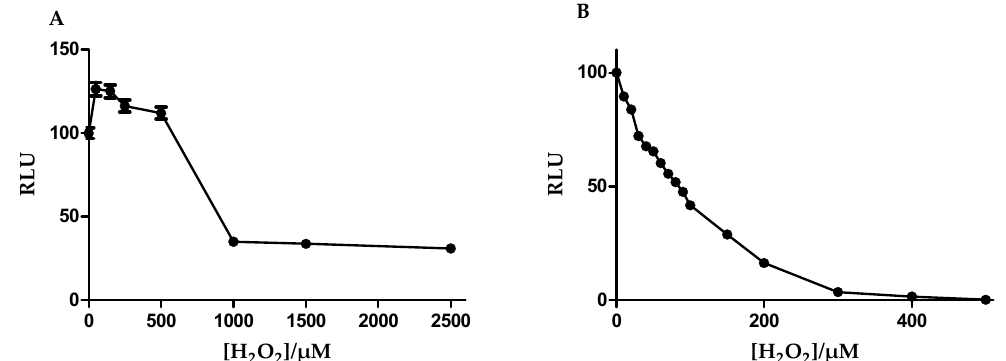
Figure 5. ( A ) and ( B ) show trends in the glutathione contents of b.End5 and bEnd3 cells with exposure to increasing [H 2 O 2 ]. Cells were exposed to increasing concentrations of [H 2 O 2 ] for 24 h and average cellular glutathione contents estimated using the GSH-Glo kit. Glutathione contents of the cells correlated directly to the relative luminescent values (RLU) obtained following incubation with the optimized reagents of the GSH-Glo assay kit described. Data in Figure 4A represents b.End5 cells and shows an upward trend in the glutathione content of the b.End5 cells upon exposure to [H 2 O 2 ] of 0–250 µ M. Above this concentration was observed a downward trend though values remained higher or at par with the starting point until [H 2 O 2 ] higher than 500 µ M. From this point a steady decline occurred until about 1 mM [H 2 O 2 ] followed by a plateau but not a complete depletion. Data in Figure 4B represent the trend in bEnd.3 glutathione changes with increasing [H 2 O 2 ]. A steady decline was observed until complete depletion at about 400 µM [H 2 O 2 ].